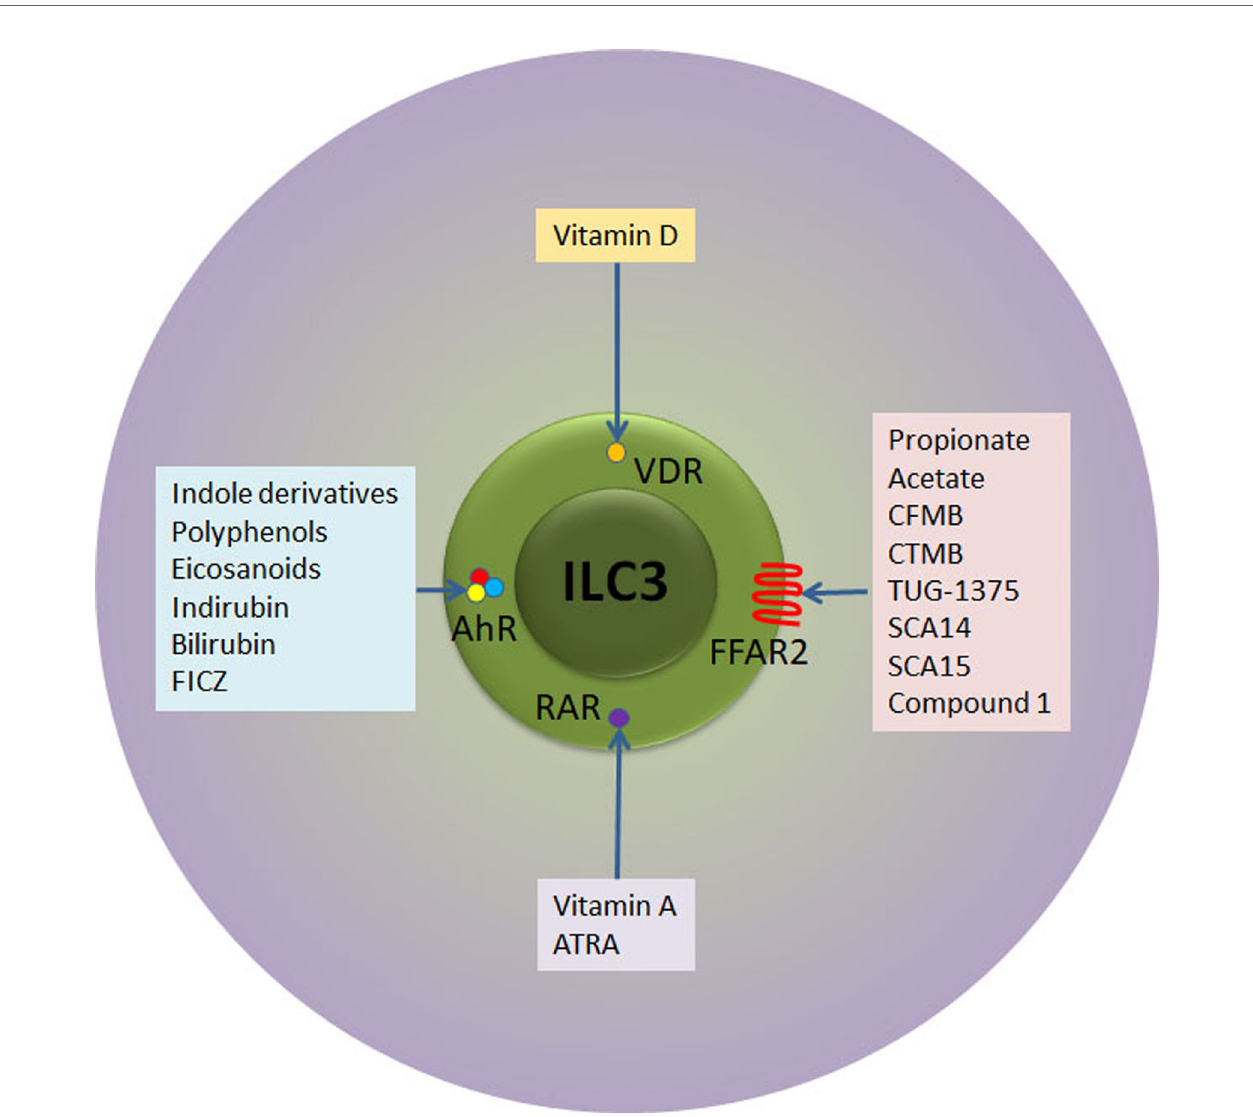
FIGURE 2 | Receptor-ligand interactions relevant for therapeutic targeting of ILC3. ILC3 express receptors for retinoic acid (RAR) and vitamin D (VDR) that upon activation with respective vitamins instigate ILC3 proliferation and/or secretion of IL-22. In addition, ILC3 express AhR transcription factor that can ligate to versatile indol-containing compounds. The activation of AhR is mandatory for the development of mature ILC3 in the intestinal lamina propria, their proliferation and IL-22 secretion. Finally, ILC3 express FFAR2 at very high levels. SCFA (propionate and acetate) as well as several synthetic compounds bind to FFAR2 with high af fi nity, while Compound 1 and CTMB are selective FFAR2 agonists that promote bene fi cial ILC3 functions. ATRA, all trans retinoic acid; FICZ, 6-formylindolo[3,2-b] carbazole; CFMB, S)-2-(4-chlorophenyl)-3,3-dimethyl- N-(5-phenylthiazol-2-yl)butamide; 4-CTMB, (S)-2-(4-chlorophenyl)-3- methyl-N-(thiazol-2-yl)butanamide; SCA14, propiolic acid; SCA15, 2-butynoic